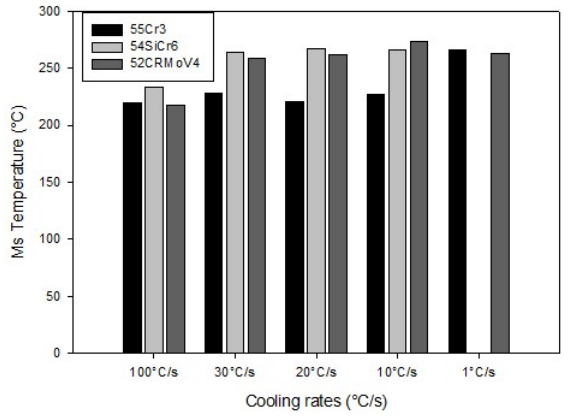
Figure 4. The effect of cooling rates on Ms temperature.